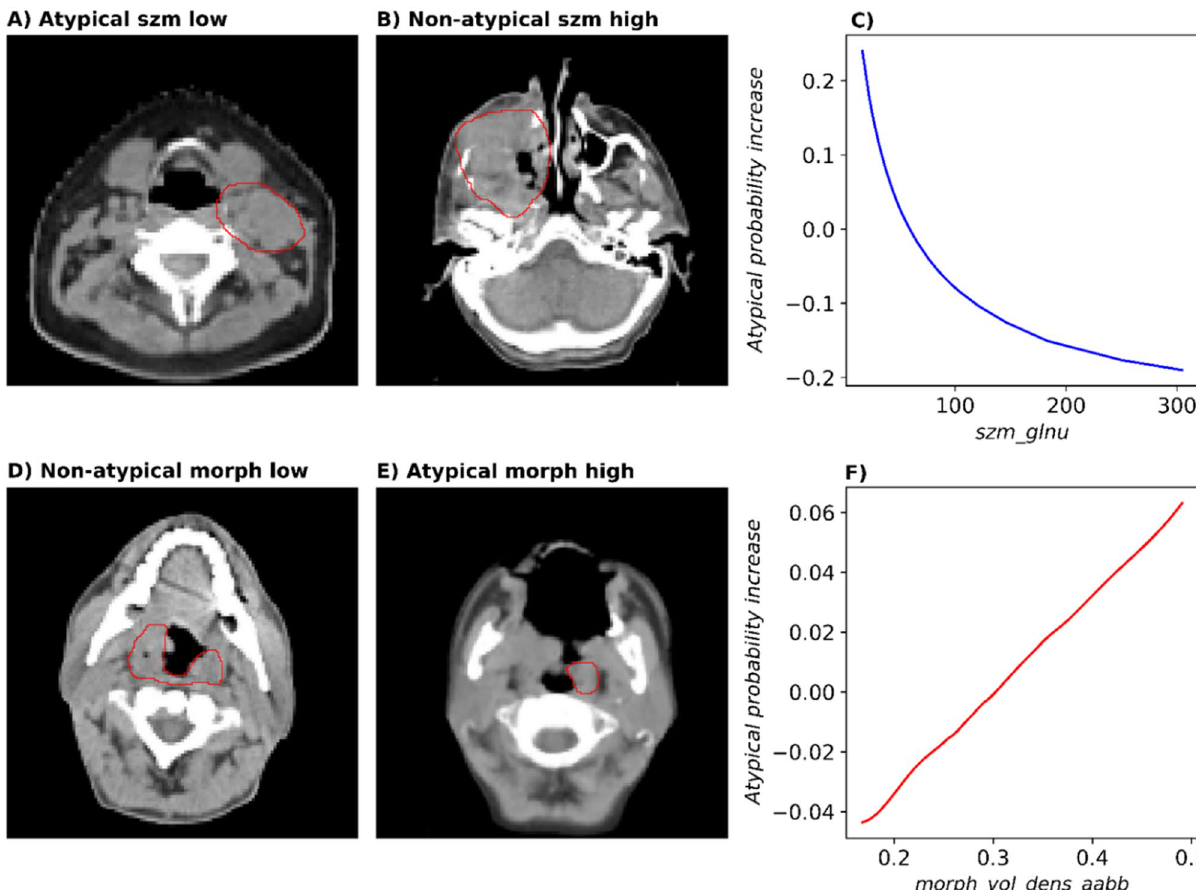
Figure 3. Representative pre-treatment CT slices (primary tumour in red) with high and low values of the two features from the radiomics model for the atypical subtype and accumulated local effects plot (ALE) in the discovery cohort. CT slices of patients with tumours that are characterised by low and high values of the texture feature grey level non-uniformity (siye zone matrix) are presented in panels ( A , B ), classified as atypical and non-atypical, respectively. A lower value of this feature represents a more spatially homogeneous tumour. The patient presented in panel ( D ) suffered from a non-atypical tumour with a low expression of the morphological feature volume density (axis-aligned bounding box). It showed a less regular shape than the atypical tumour of the patient in panel ( E ) with high feature expression. ALE plots ( C , F ) show difference in probability of being classified as atypical compared to an average patient for each feature